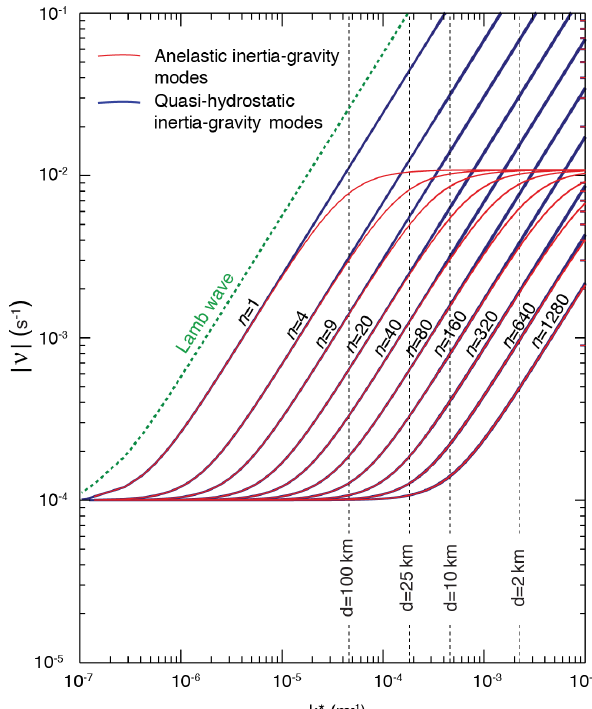
Figure 15. Plots of the absolute value of frequency for inertia– gravity modes obtained with the anelastic (red curves) and the quasi-hydrostatic (black curves) systems. The frequency of Lamb wave with the quasi-hydrostatic system is indicated with the dashed green